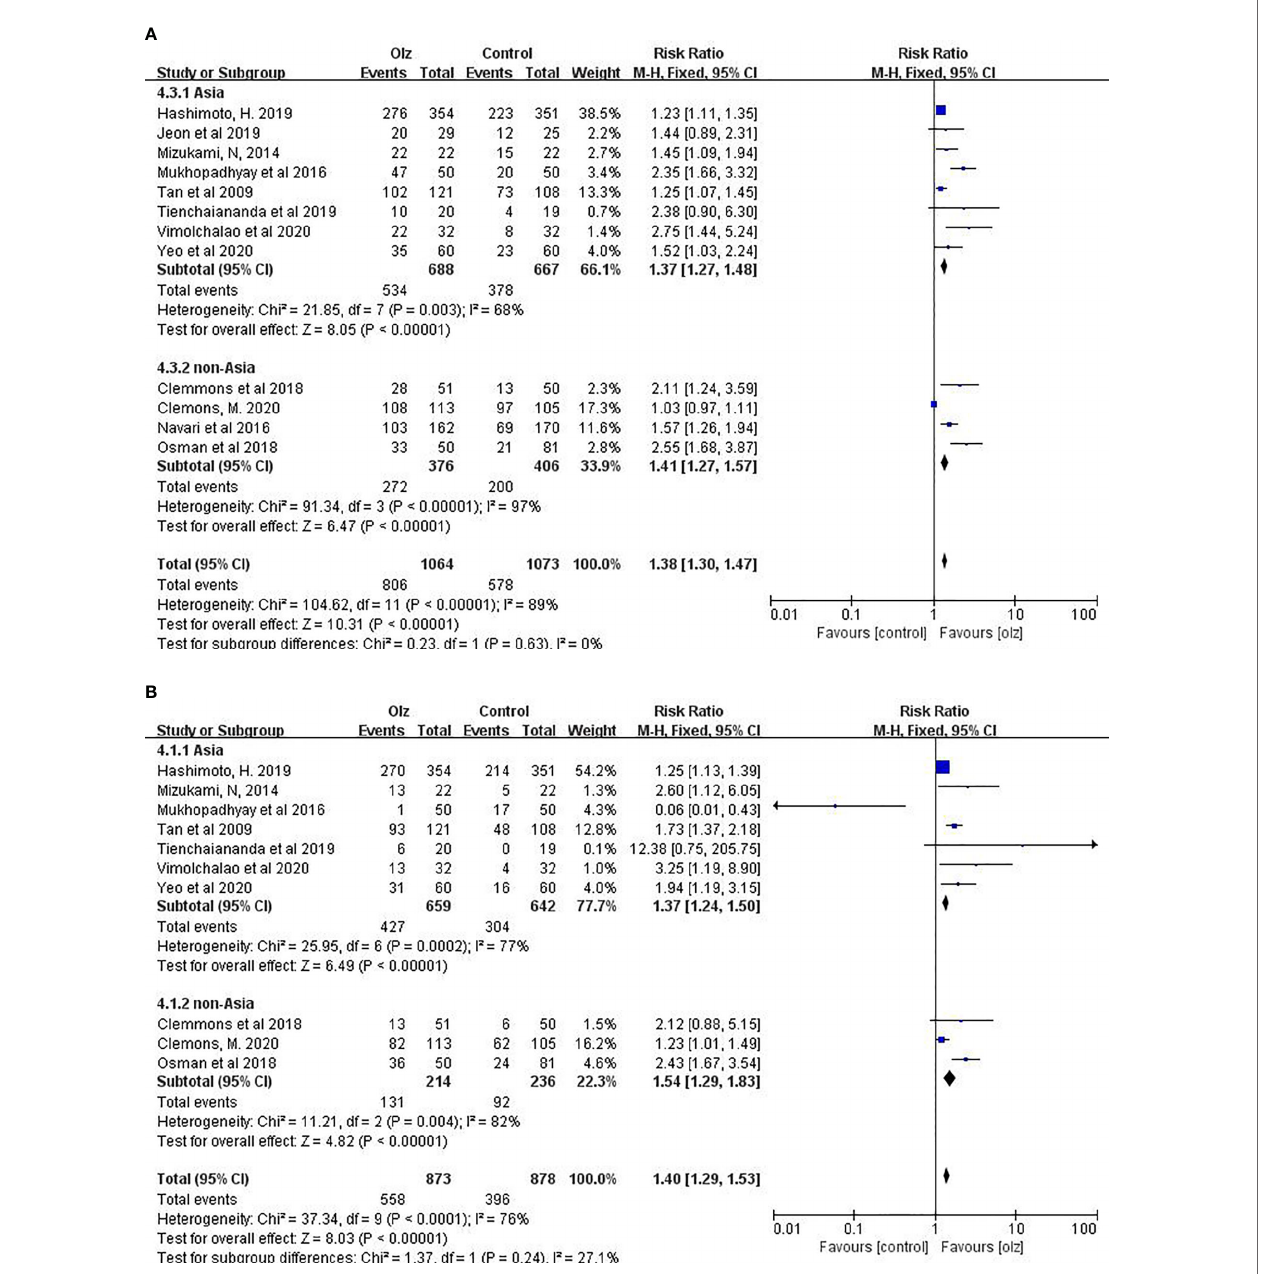
FIGURE 4 | Subgroup analysis of different regions. (A) CR of Olz for Asia or non-Asia countries. (B) CR of Olz for Asia or non-Asia